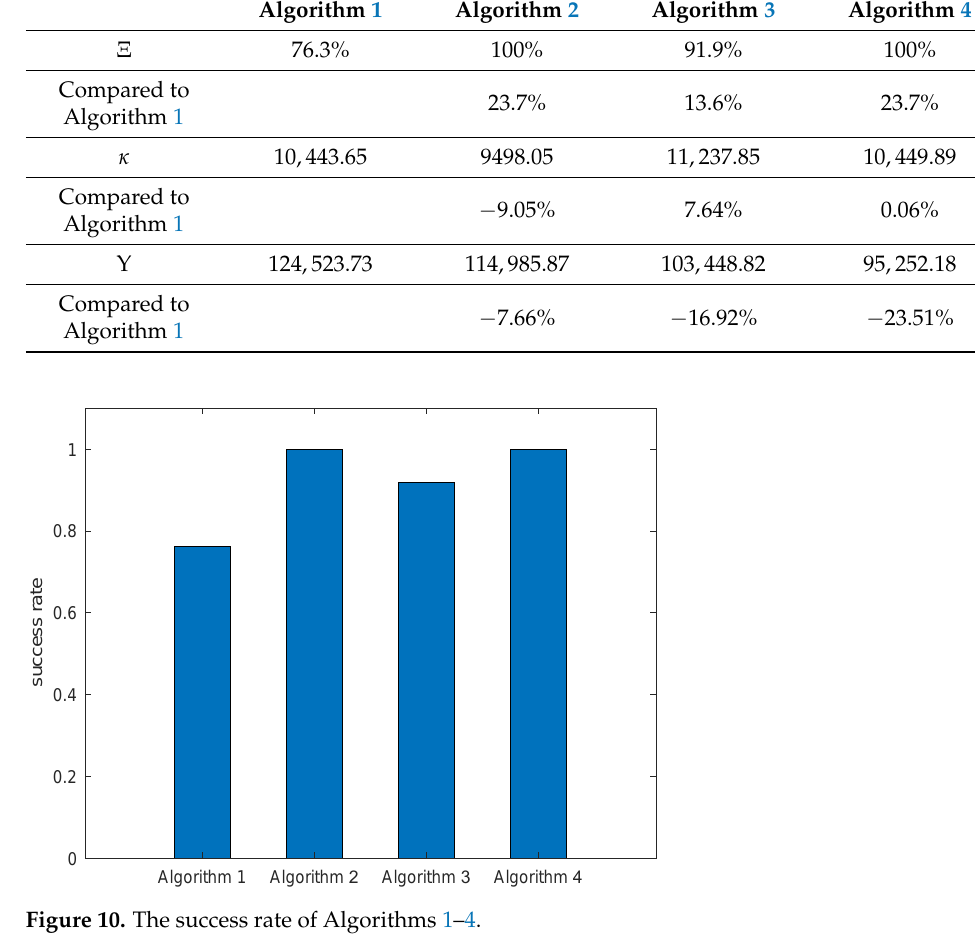
Figure 10. The success rate of Algorithms 1–4.